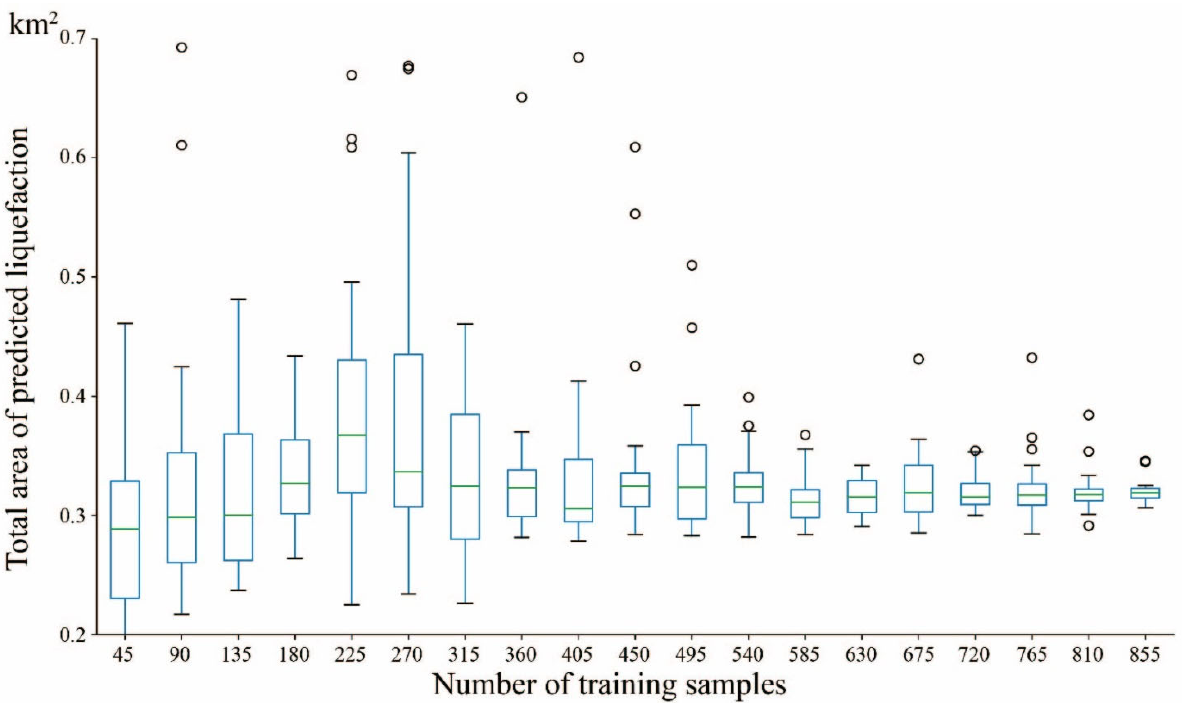
Figure 11. The relationship between the total area of extracted liquefaction by RF and the number of training samples.